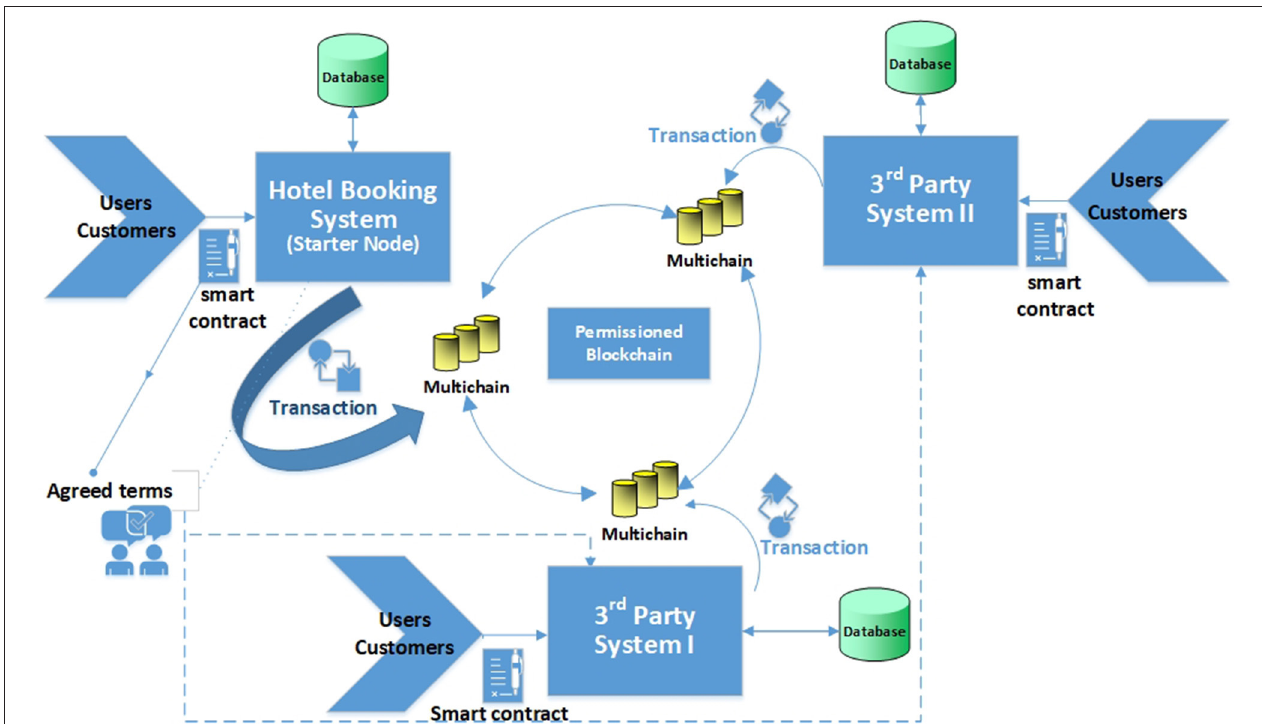
FIGURE 2 | User-controlled privacy-preserving data sharing platform in the travel booking